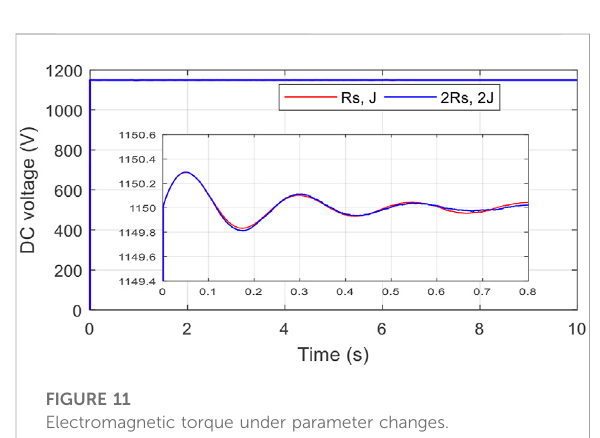
FIGURE 11 Electromagnetic torque under parameter changes.